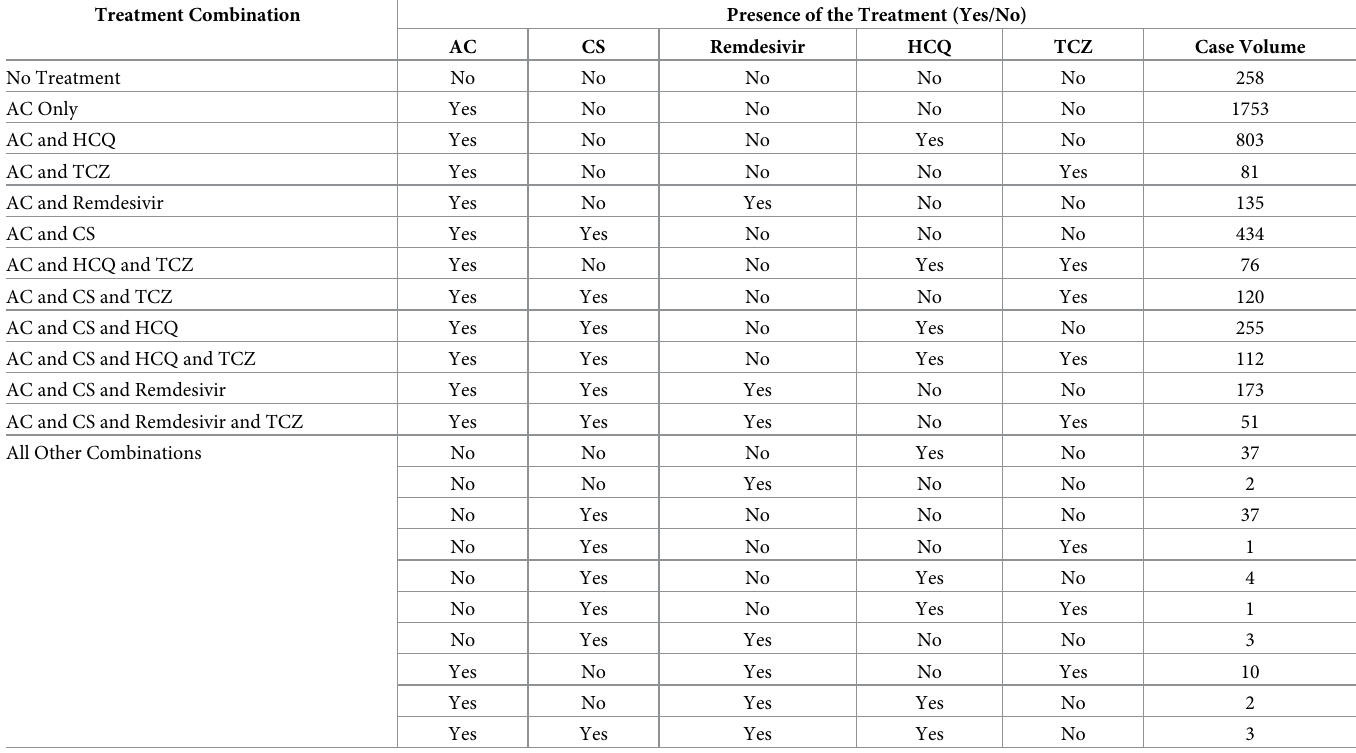
care, for predictors of mortality (Table 3). For the overall population, four medication catego- ries had significant negative correlation estimates for mortality: Anticoagulation Only (OR 0.24, p < 0.0001), Anticoagulation and Remdesivir (OR 0.25, p = 0.0031), Anticoagulation and Corticosteroids (OR 0.53, p = 0.0263), and Anticoagulation and Corticosteroids and Remdesi- vir (OR 0.42, p = 0.026). Treatment combinations that included tocilizumab and/or hydroxy- chloroquine were not statistically significant. Mortality was also evaluated based on level of care—non-ICU versus ICU patients (Table 3). The mortality rate was much higher in ICU patients compared to non-ICU patients —40.9% versus 6.3%, respectively. As in the model of all inpatients, the non-ICU model found that the same four treatment combinations were associated with lower mortality: Table 2. Medication combinations used to treat COVID-19. Treatment